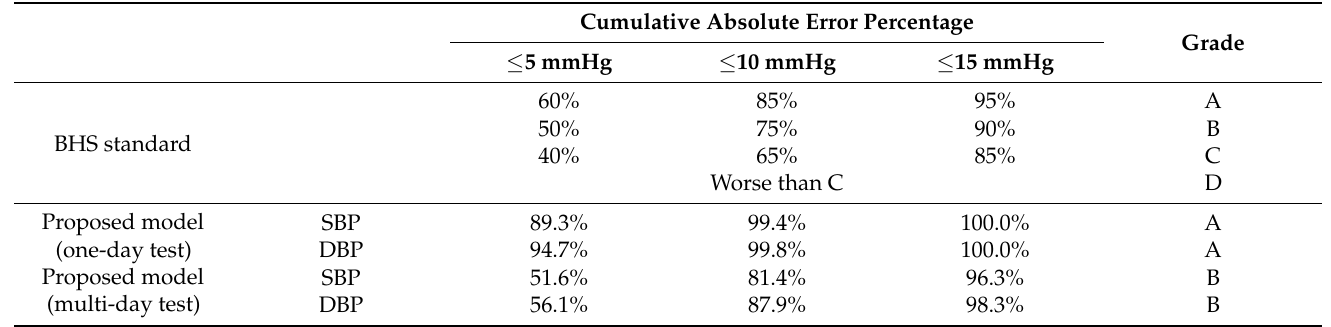
Table 6. Performance evaluation using British Hypertension Society (BHS) standard.